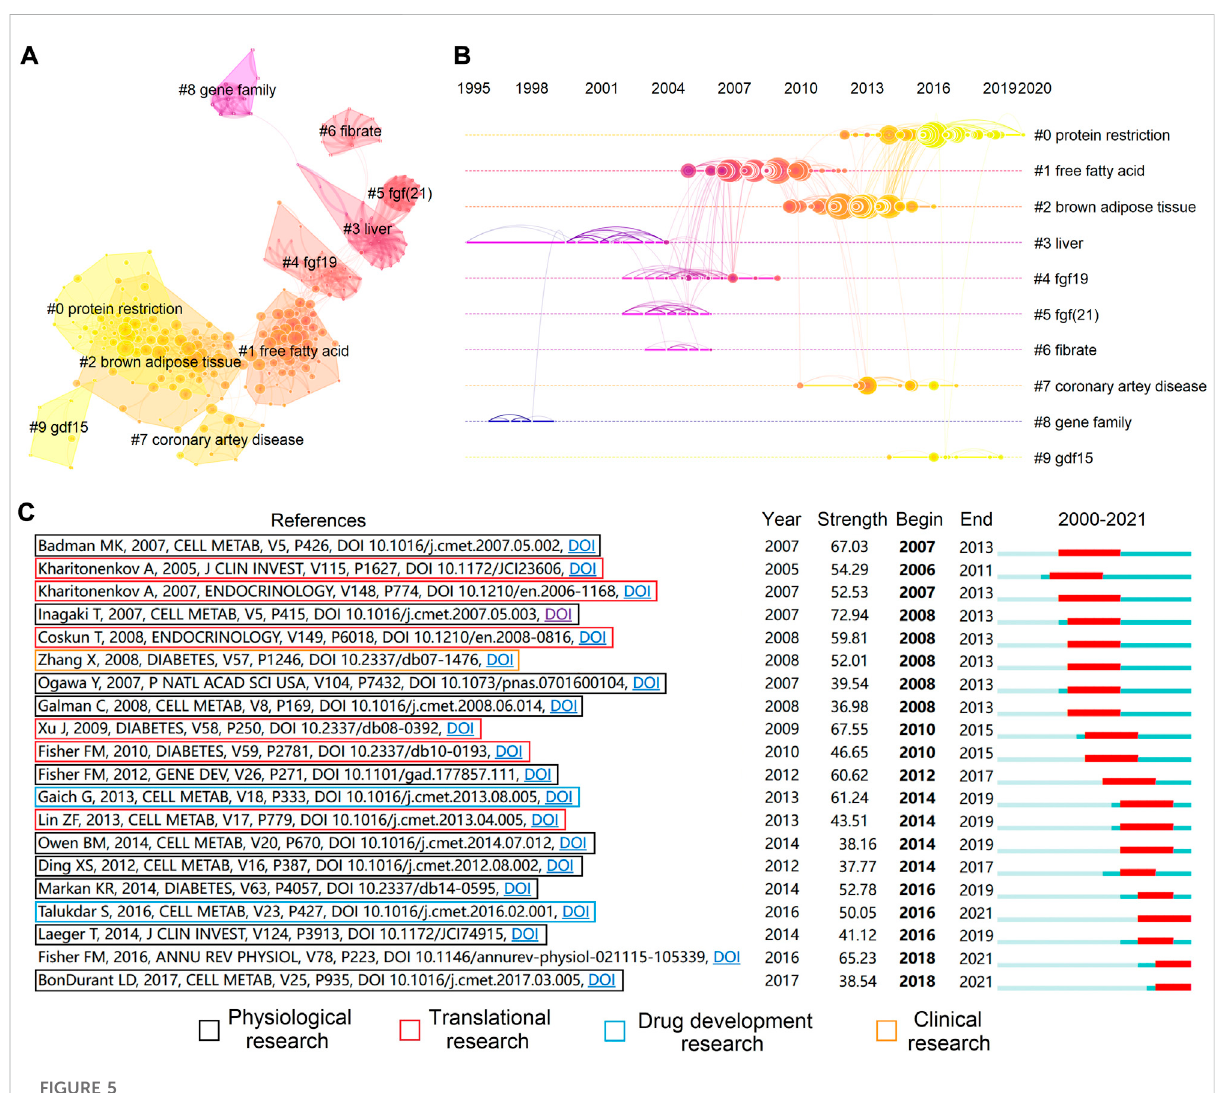
FIGURE 5 Co-citedreferences analysis. (A) Cluster analysisof co-cited references. Each line indicates a co-cited relationship. (B) Timeline view of theten clusters. The position of the node on the horizontal axis indicates the time point of the fi rst appearance, and each line represents a co-cited relationship. The size of each node is proportional to the number of citations. (C) The top twenty references with the highest citation